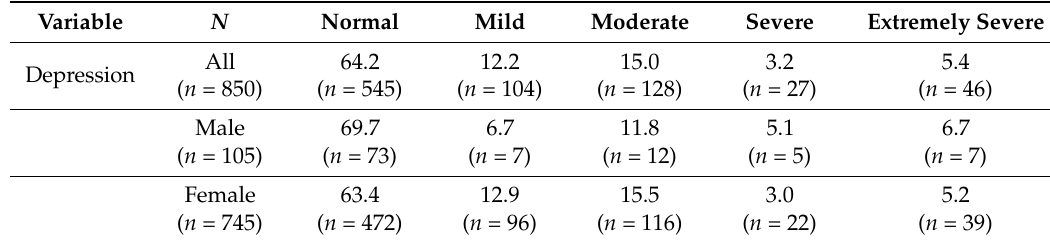
Table 3. Severity distribution (%) of Depression scores among nurses in the present survey. Variable N Normal